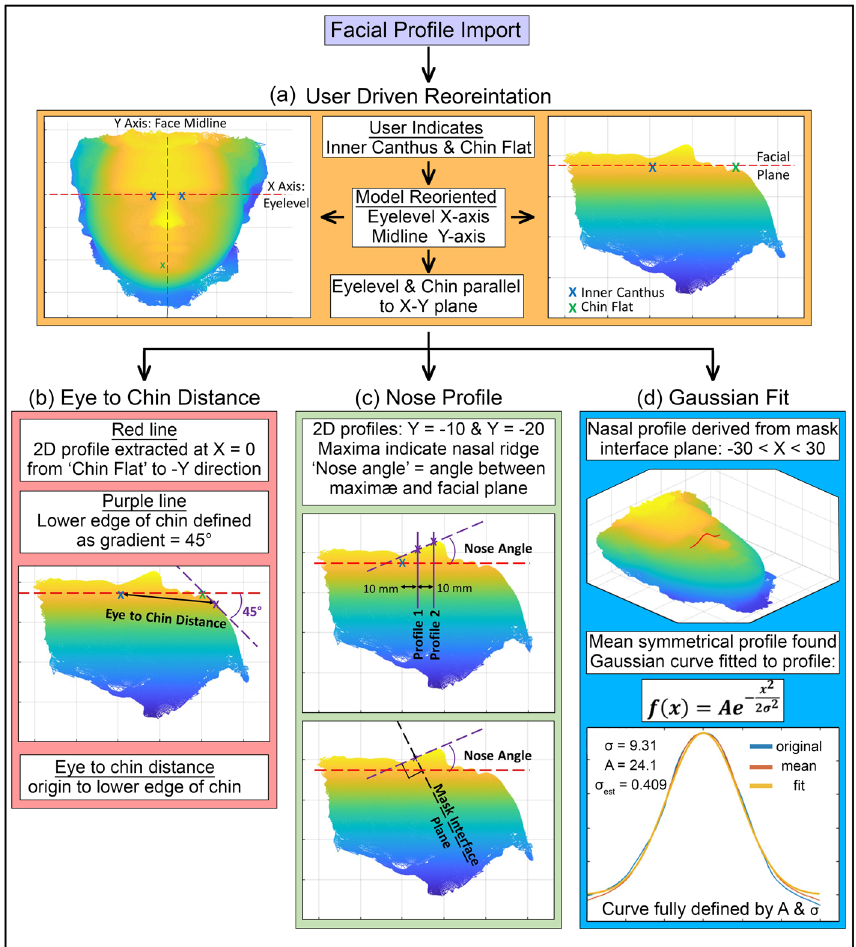
Figure 2. Diagram showing facial scan data processing logic for key parameter extraction as applied within the custom MATLAB script. ( a ) Shows the orientation stage with blue crosses indicating user input and red dashed lines showing the relevant axes/planes. ( b ) Illustrates the method for eye-to-chin distance measurement. ( c ) Illustrates nose profile extraction ( d ) shows the Gaussian fit to the extracted nose